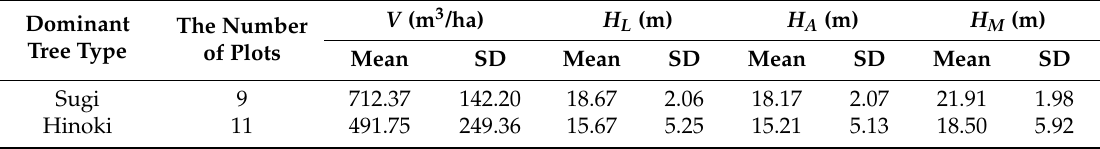
Table 1. Summary of the biophysical properties, which were stand volume ( V ), Lorey’s mean height ( H L ), mean height ( H A ), and max height ( H M ), calculated from field measurements (SD indicates the standard